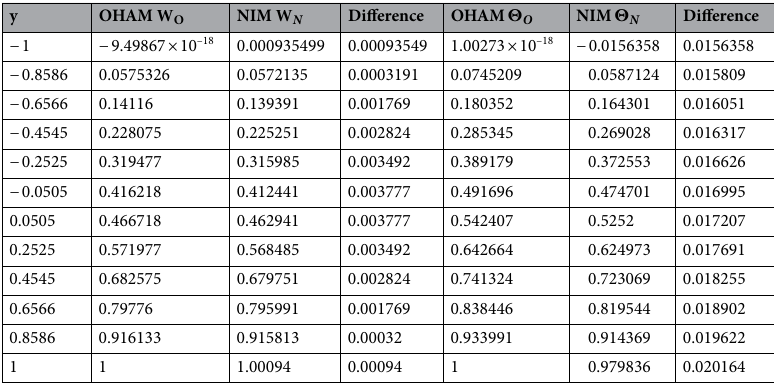
Table 4. For (cid:31) = 0.1, M = 0.0015, B = 0.4 and A =